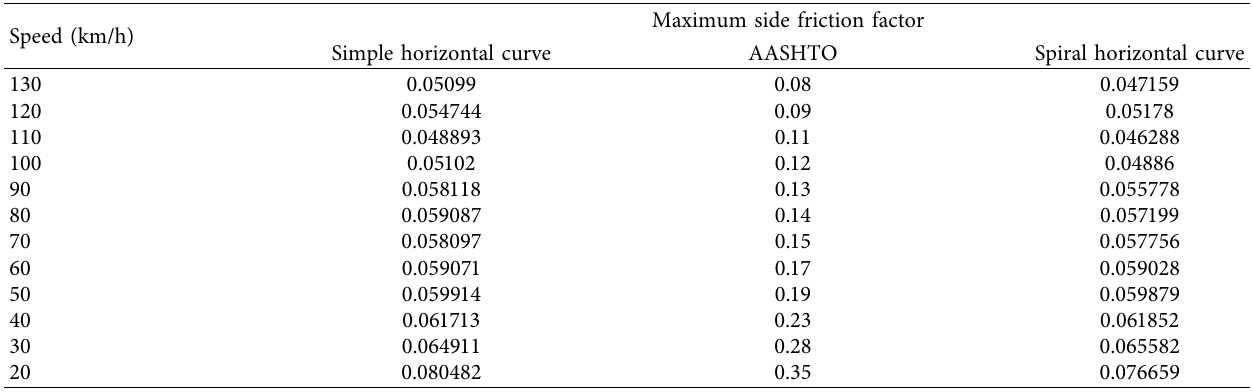
Table 8: Comparison of the maximum side friction factor for a truck between simple and spiral horizontal curves and AASHTO rec- ommended values at a radius of 1.1R.